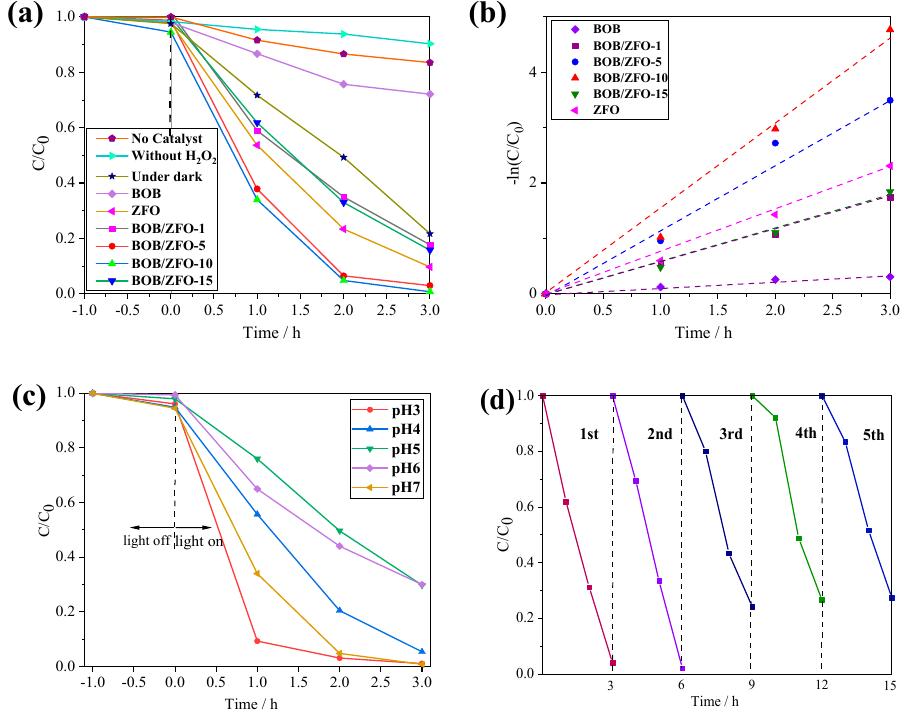
Figure 9. ( a ) TCH photodegradation activity over as-fabricated samples under visible light ( λ > 420 nm); ( b ) the pseudo-first-order kinetic rate constants over all materials; ( c ) TCH photodegradation activity under various pH conditions (BOB/ZFO-10); ( d ) cycling degradation curves of TCH for BOB/ZFO-10 sample.